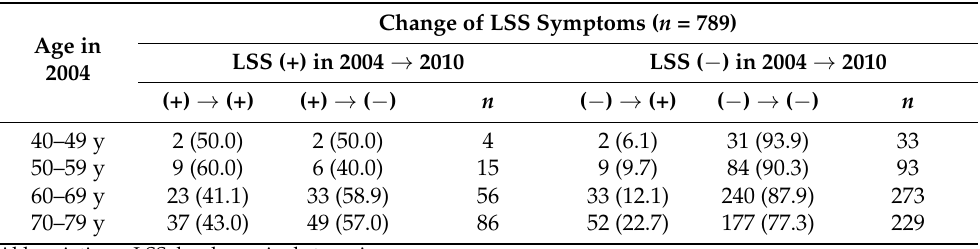
Abbreviations: LSS, lumbar spinal